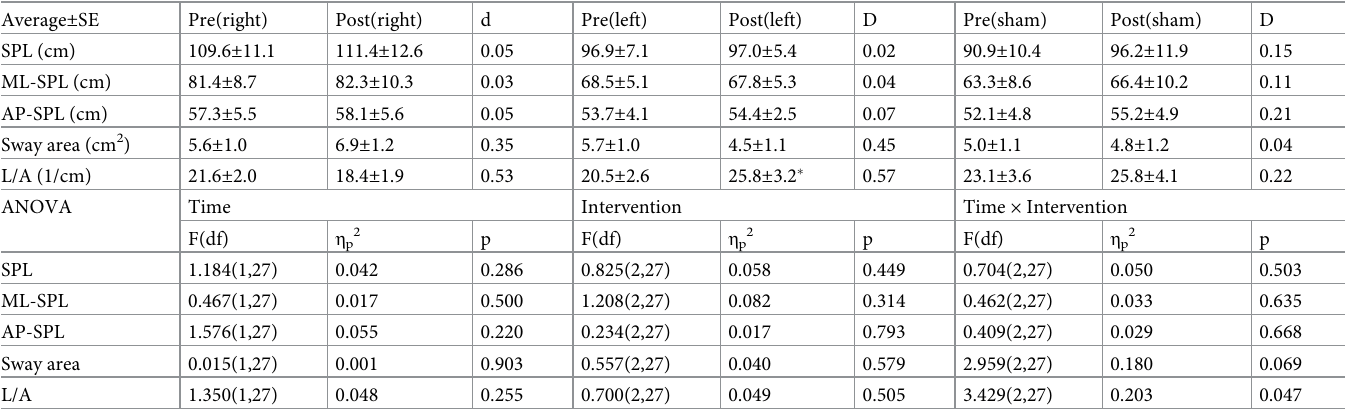
Table 2. Effect of C-tDCS in SPL, ML-SPL, AP-SPL, sway area and L/A with EC condition. Average ± SE